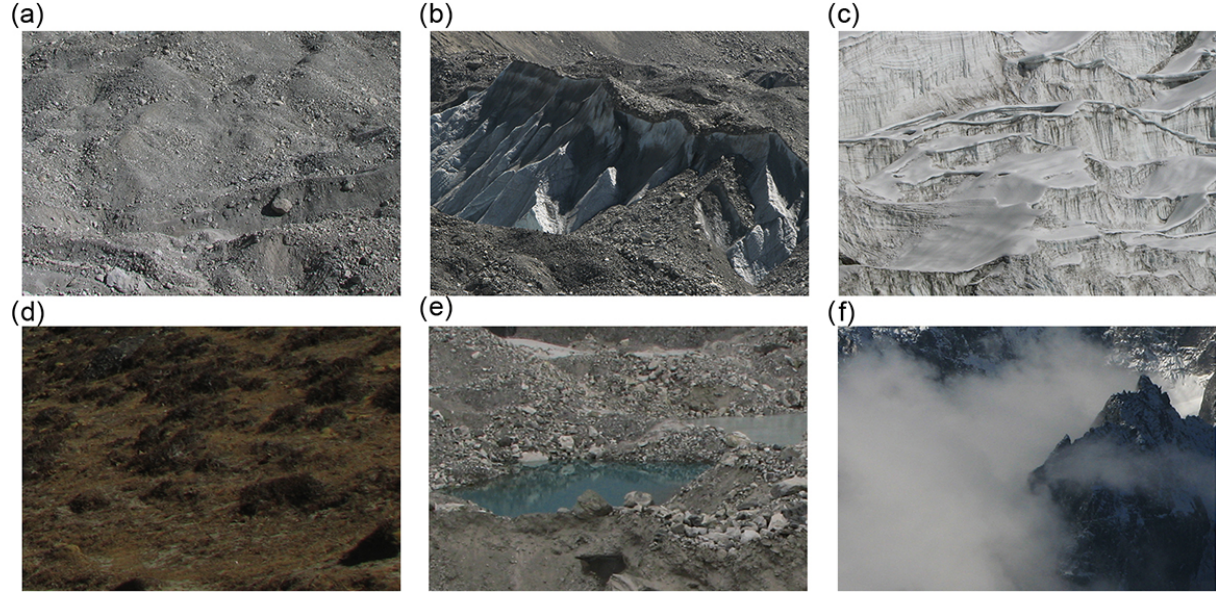
Figure 3. Types of surfaces present in the study area: (a) light debris cover (quartz, feldspar); (b) darker schistic debris with ice cliff; (c) clean ice with crevasses in the glacier ablation area; (d) graminoid shrub type vegetation (dry); (e) supraglacial lakes with different turbidity levels; (f) valley clouds. All photos were taken in the Khumbu region. Photo credit: Adina E. Racoviteanu.